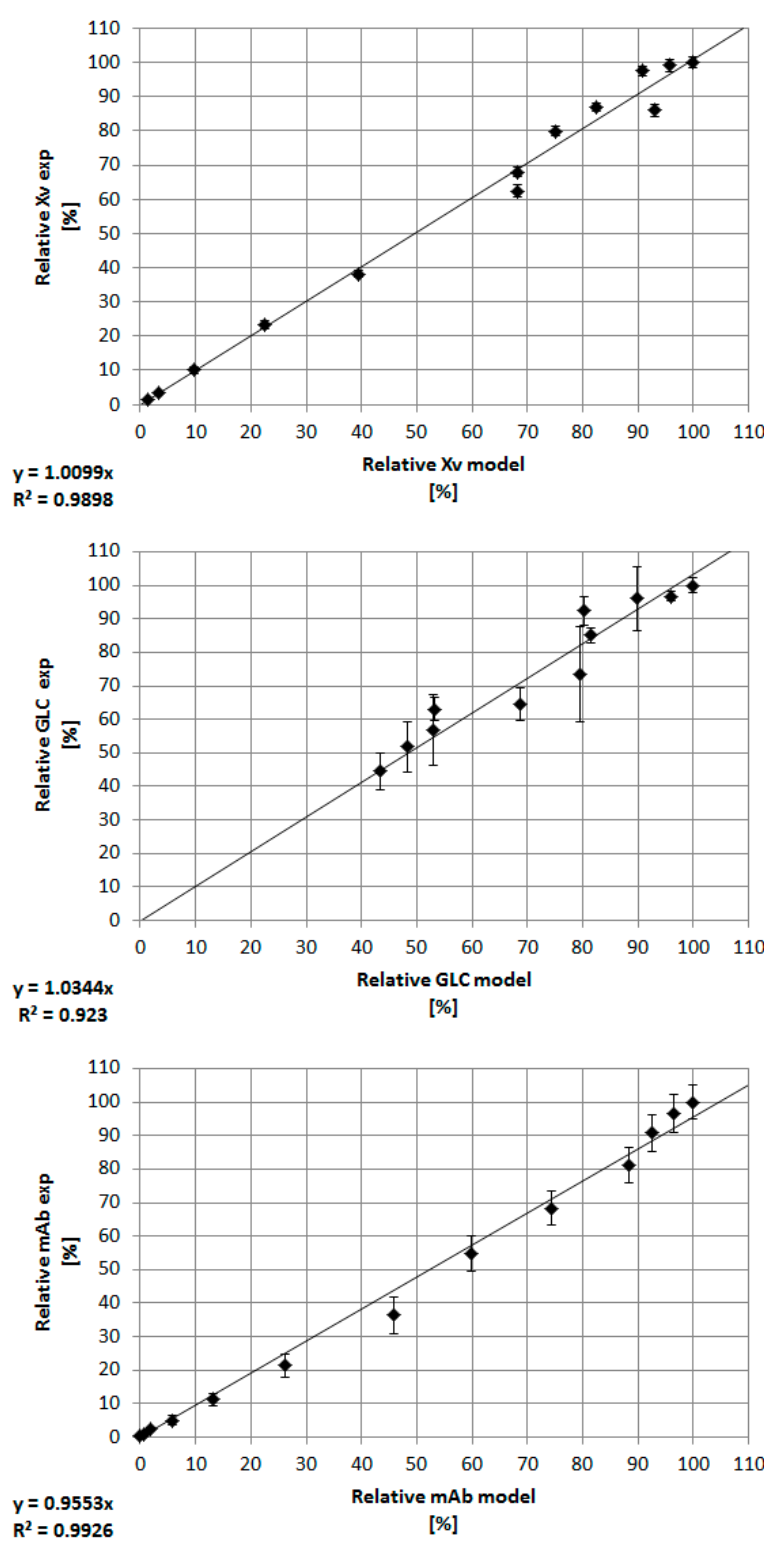
Figure 9. Correlation between experimental and predicted values for the viable cell, product, and glucose concentration. The error bars represent the standard deviation of various bioreactor cultivations. The coefficient of determination is ≥ 0.92.